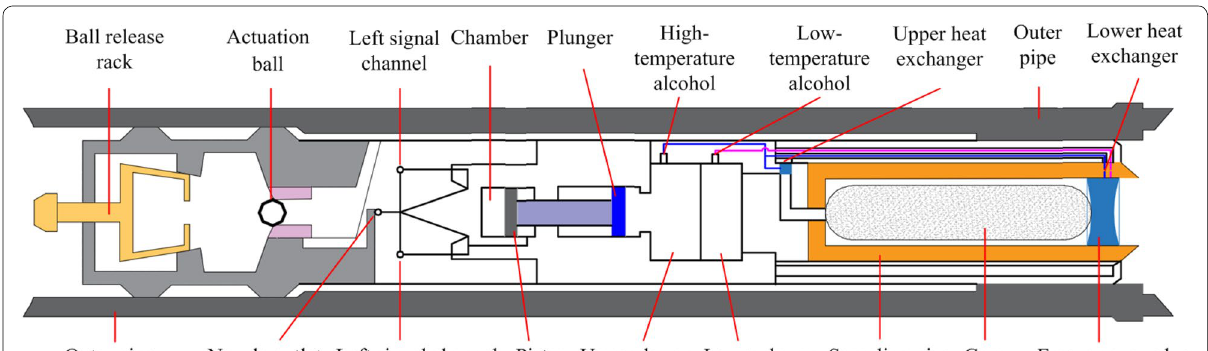
Figure 9 Schematic of the wire line ice-valve-based pressure corer (IVBP)